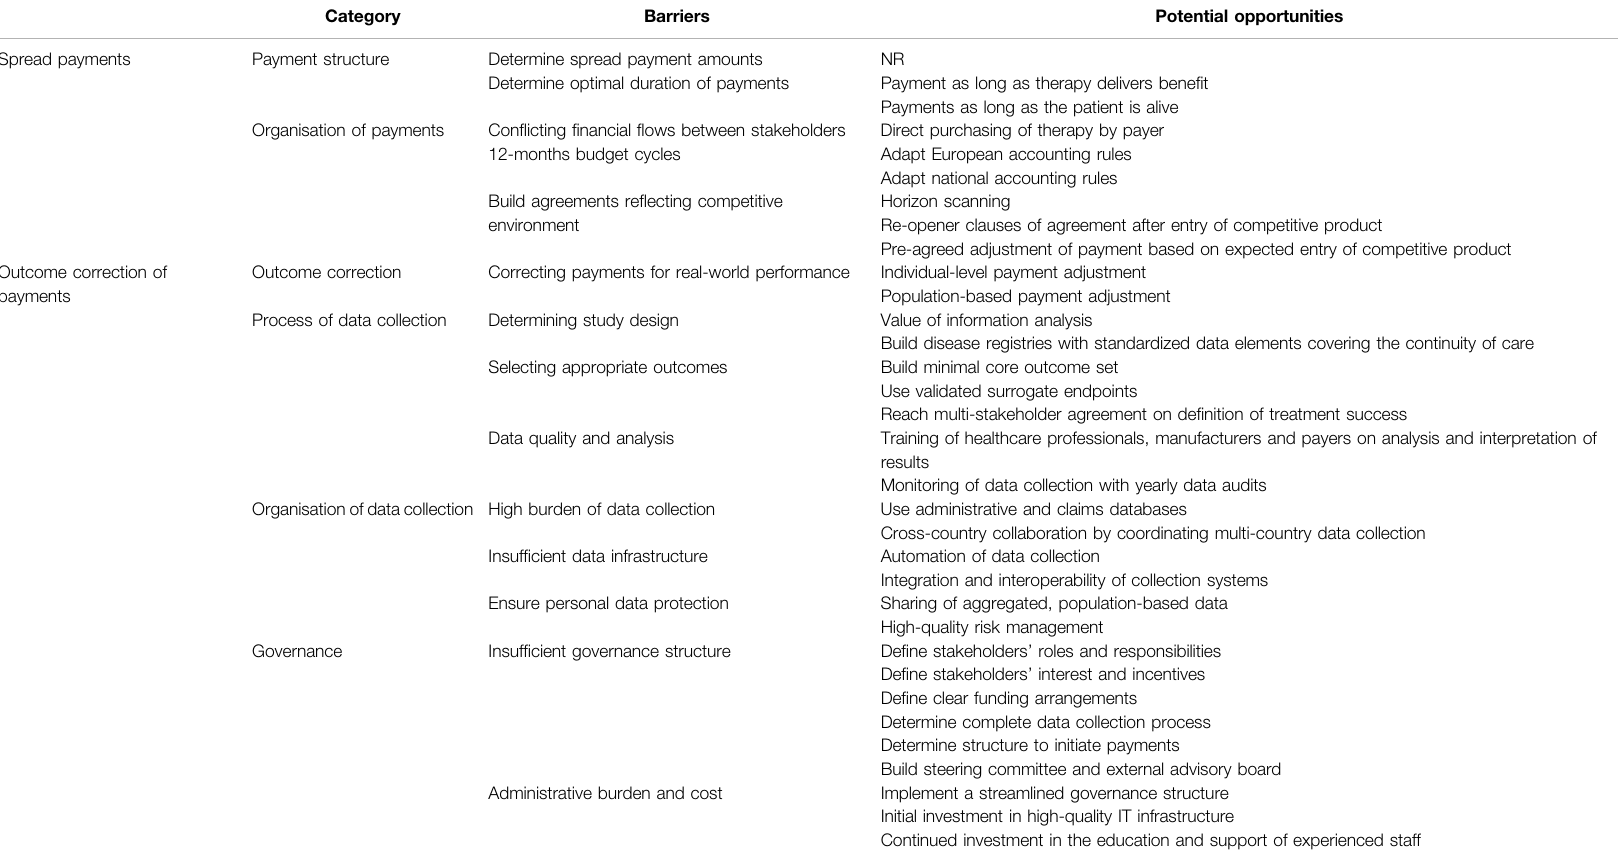
TABLE 1 | Categories for which barriers and proposed opportunities for the implementation of spread payments and the outcome correction of payments were identi fi